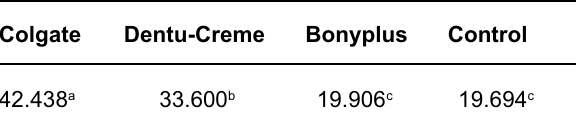
Different letters indicate statistically significant difference